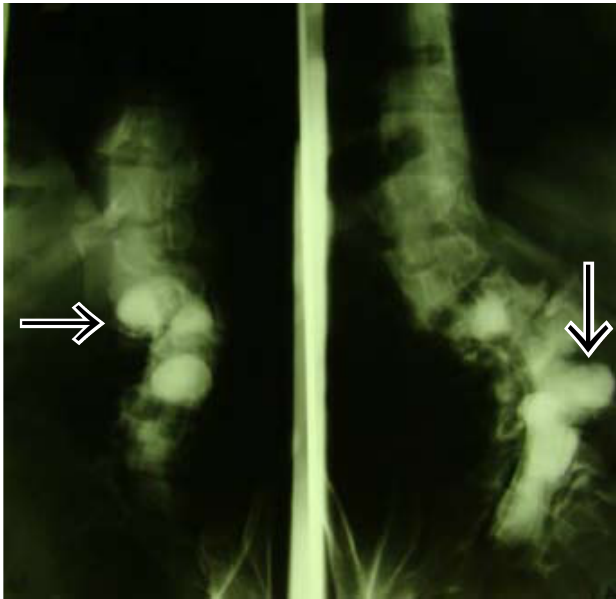
Fig. 8b. Myelogram of the lumbar spine in a different patient showing multilevel vertebral anomalies and dural